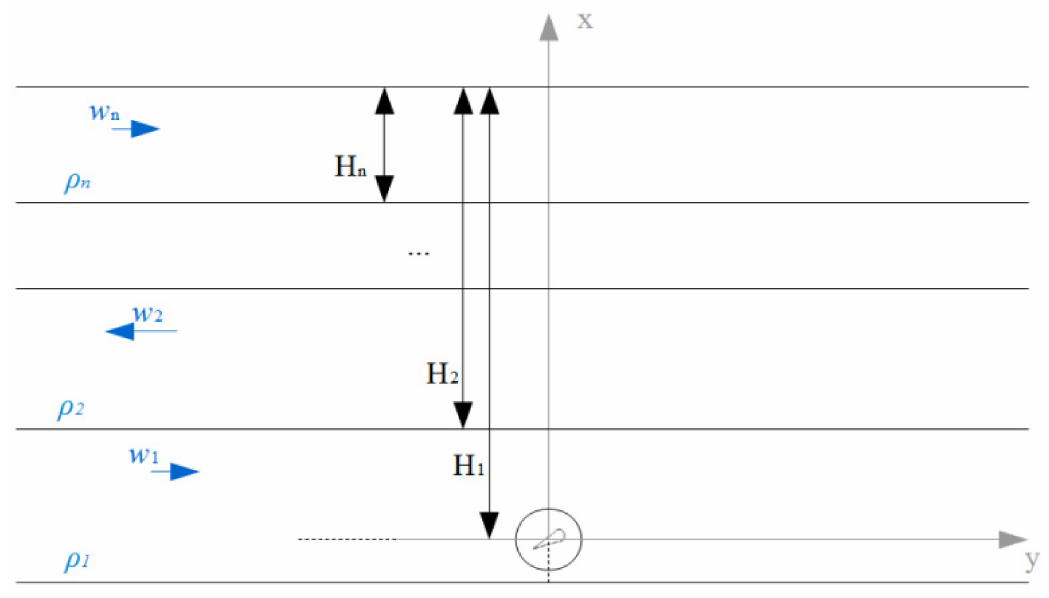
Figure 1. Structure of a stratified continuous